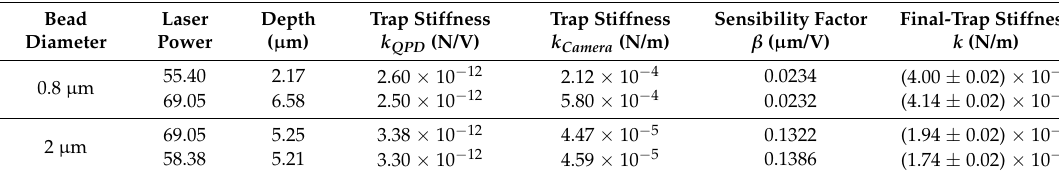
Table 1. Summary of trap parameters measured in x direction.